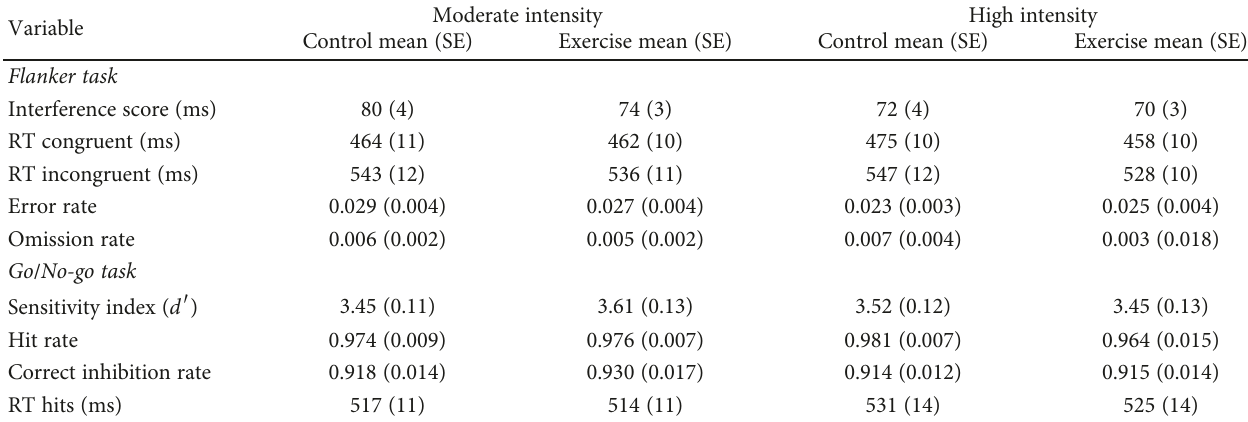
Table 2: Behavioral performance during the executive function tasks for each group and